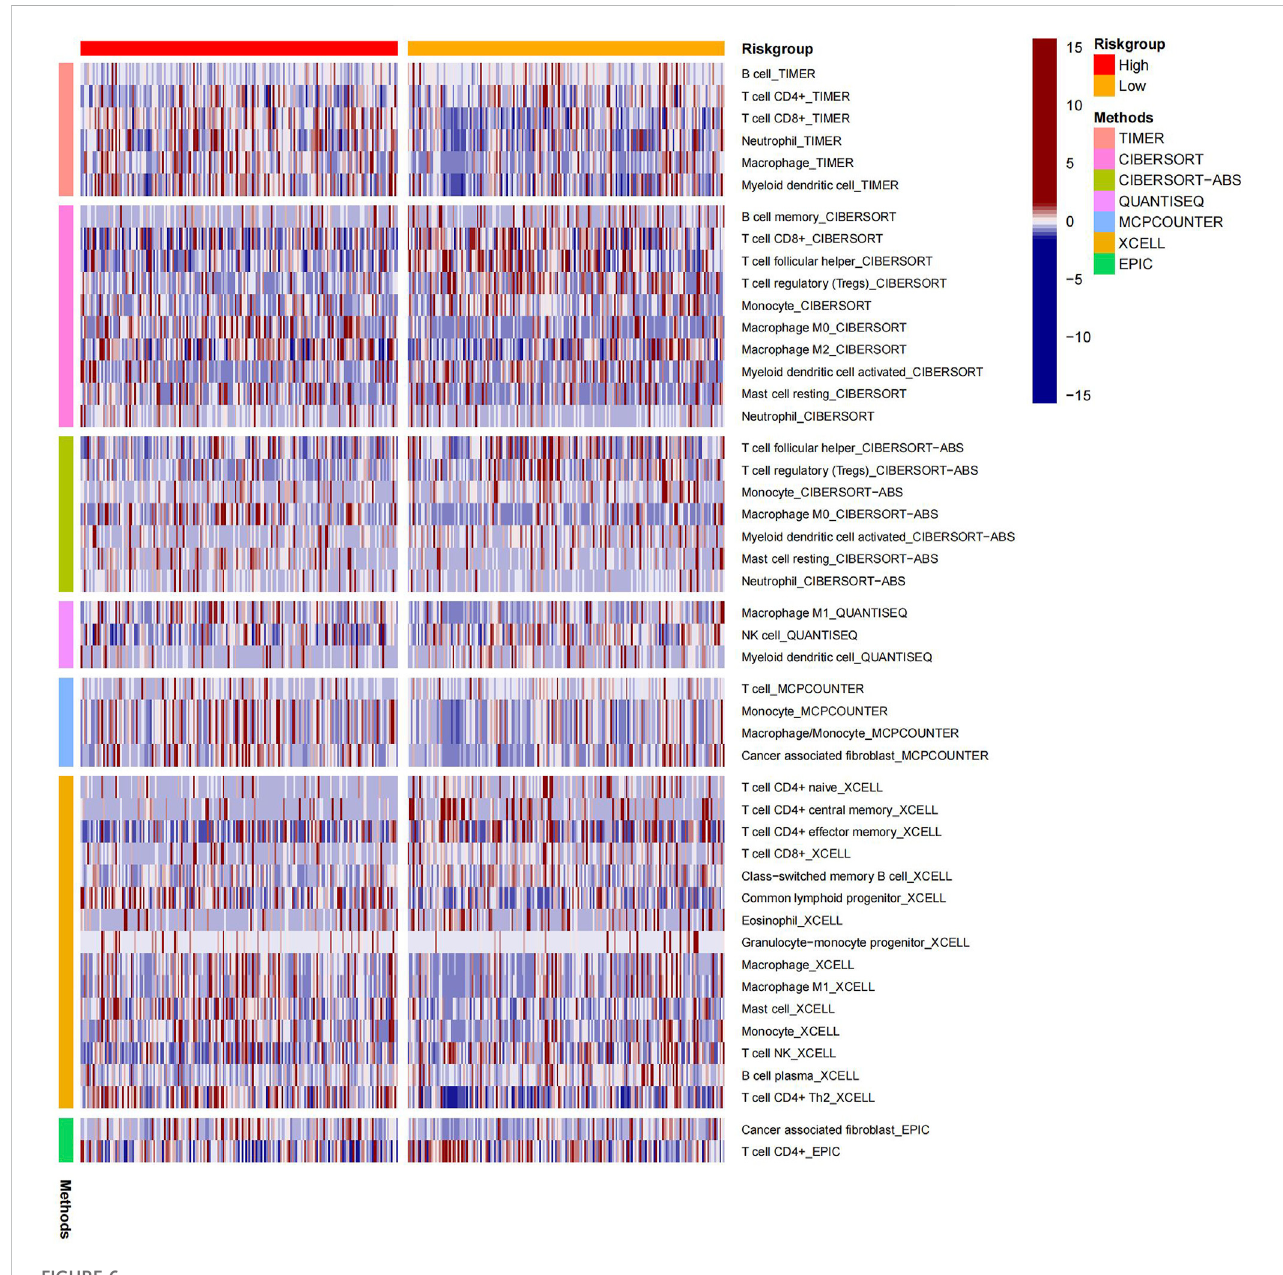
FIGURE 6 Heat map of immune cell in fi ltration in high and low-risk